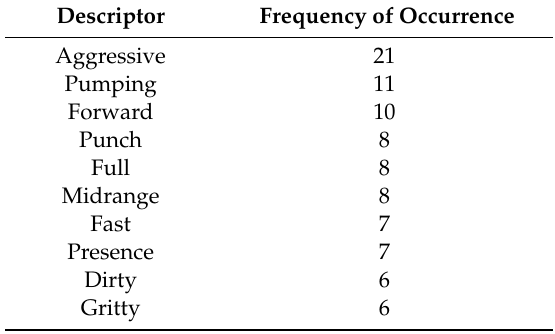
Table 1. The top ten most frequently used descriptors to describe the sound of the 1176 compression.